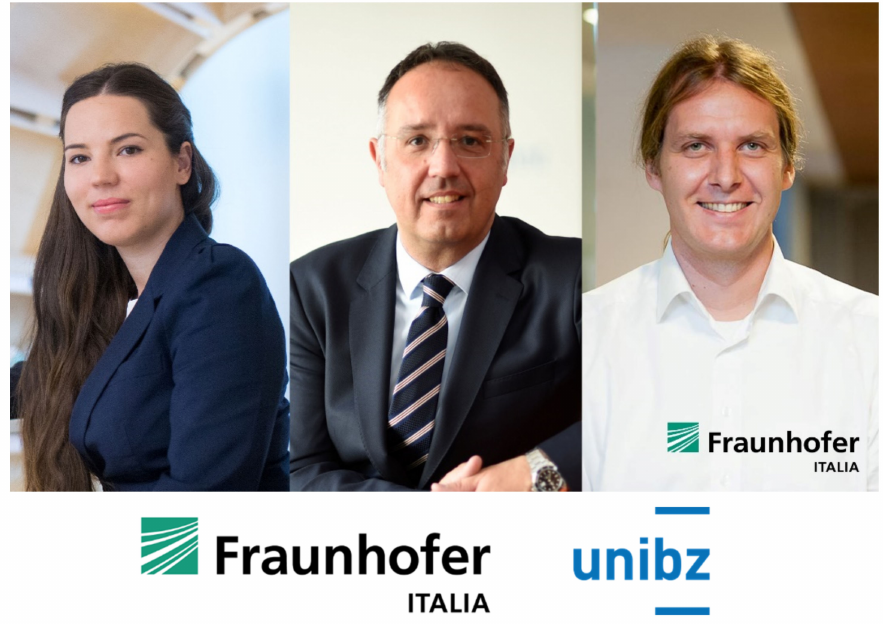
Figure 3. Research group from left to right: Julia Ratajczak obtained her PhD degree at the Faculty of Science and Technology at the Free University of Bozen-Bolzano and she is currently working